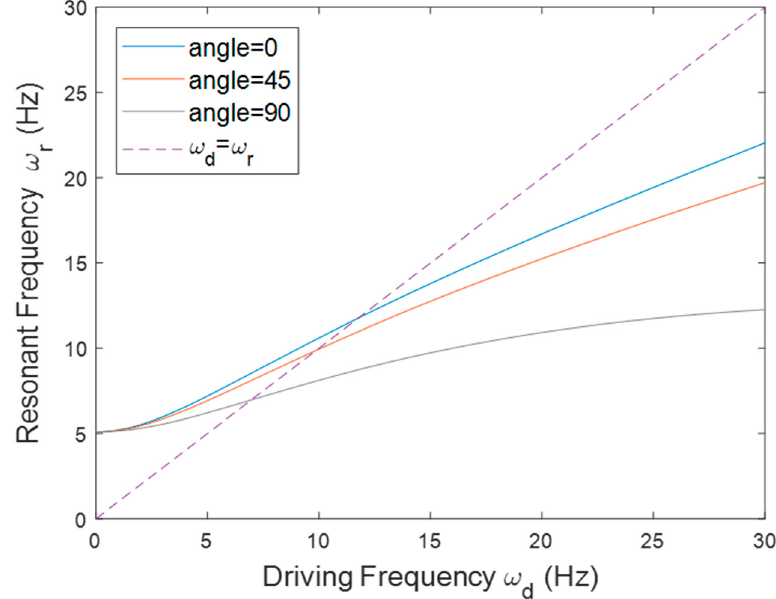
Figure 9. The resonant frequency of the PEH in the tilted configuration with different θ .